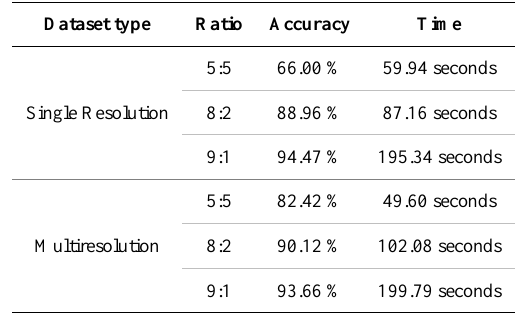
Table 3. Proposed model